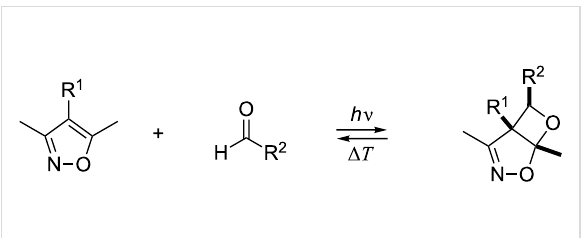
Scheme 7: T-type photochromism of isoxazole–aldehyde pairs.